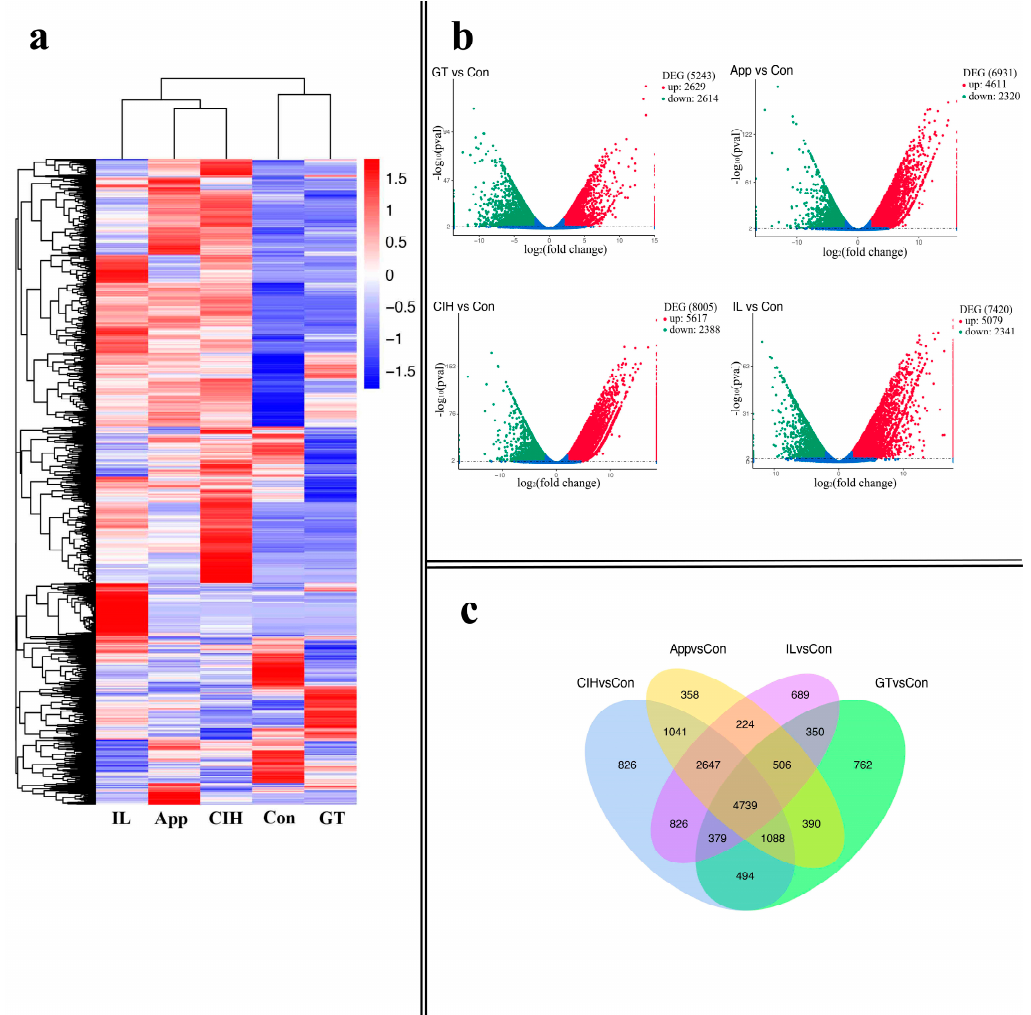
Figure 2. Identification and expression profile analyses of di ff erentially expressed genes (DEGs). ( a ) Expression profile and clustering of DEGs in di ff erent growth stages of C. camelliae . ( b ) The number of up-regulated and down-regulated DEGs was compared with Con at di ff erent growth stages. ( c ) Overlapping relationship of DEGs between di ff erent comparable groups. (Con: conidium; GT: germ tube; App: appressoria; CIH: cellophane infectious hyphae; IL: infection